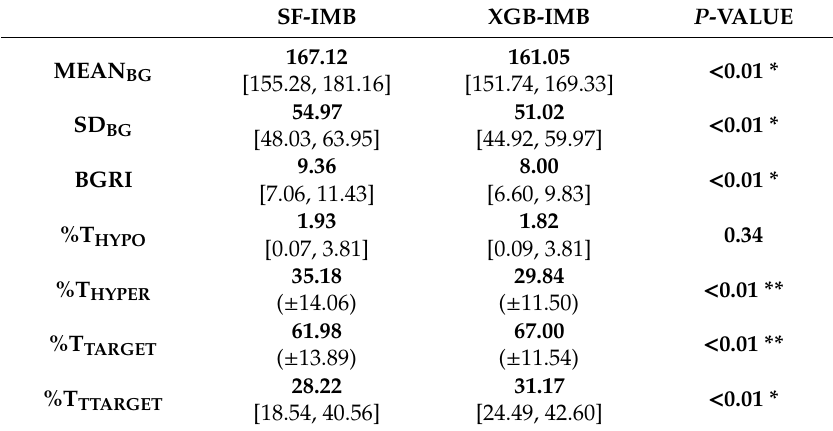
Table 1. Obtained on 80 virtual adult subjects on Scenario